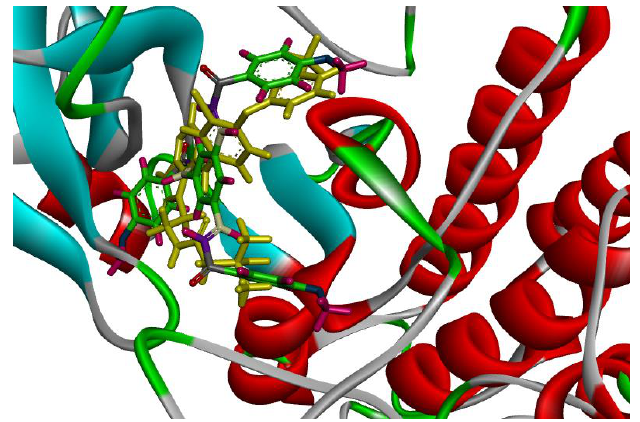
Figure 4. Solid ribbon representation of 3POZ docked with the crystal structure of TAK-285 (yellow color) and inhibitor 1d (colored) in the active site.